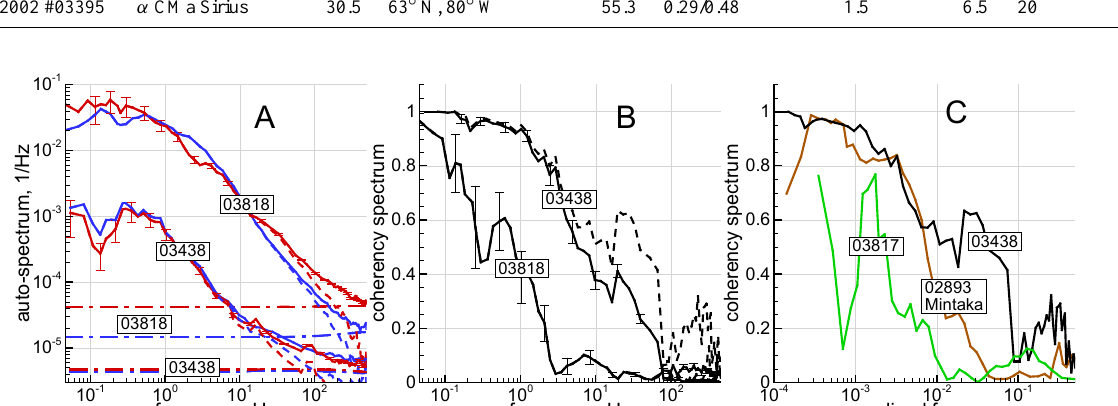
Figure 3. (A) experimental auto-spectra and detected isotropic and anisotropic components of these spectra. Solid lines: experimental spectra, dot-dashed lines: estimates of the isotropic component, dashed lines: estimates of the anisotropic component. Colors of the lines in (A) correspond to wavelengths of the photometers. Error bars show rms uncertainty of the spectral density estimates (error bars are shown only for the red-photometer auto-spectra; for the blue photometer, uncertainties are the same). (B) coherency spectra of measured scintillations (solid lines) and of anisotropic component (dashed lines). (C) coherency spectra of the anisotropic scintillation component presented as a function of the normalized frequency numbers in boxes are the orbit numbers.